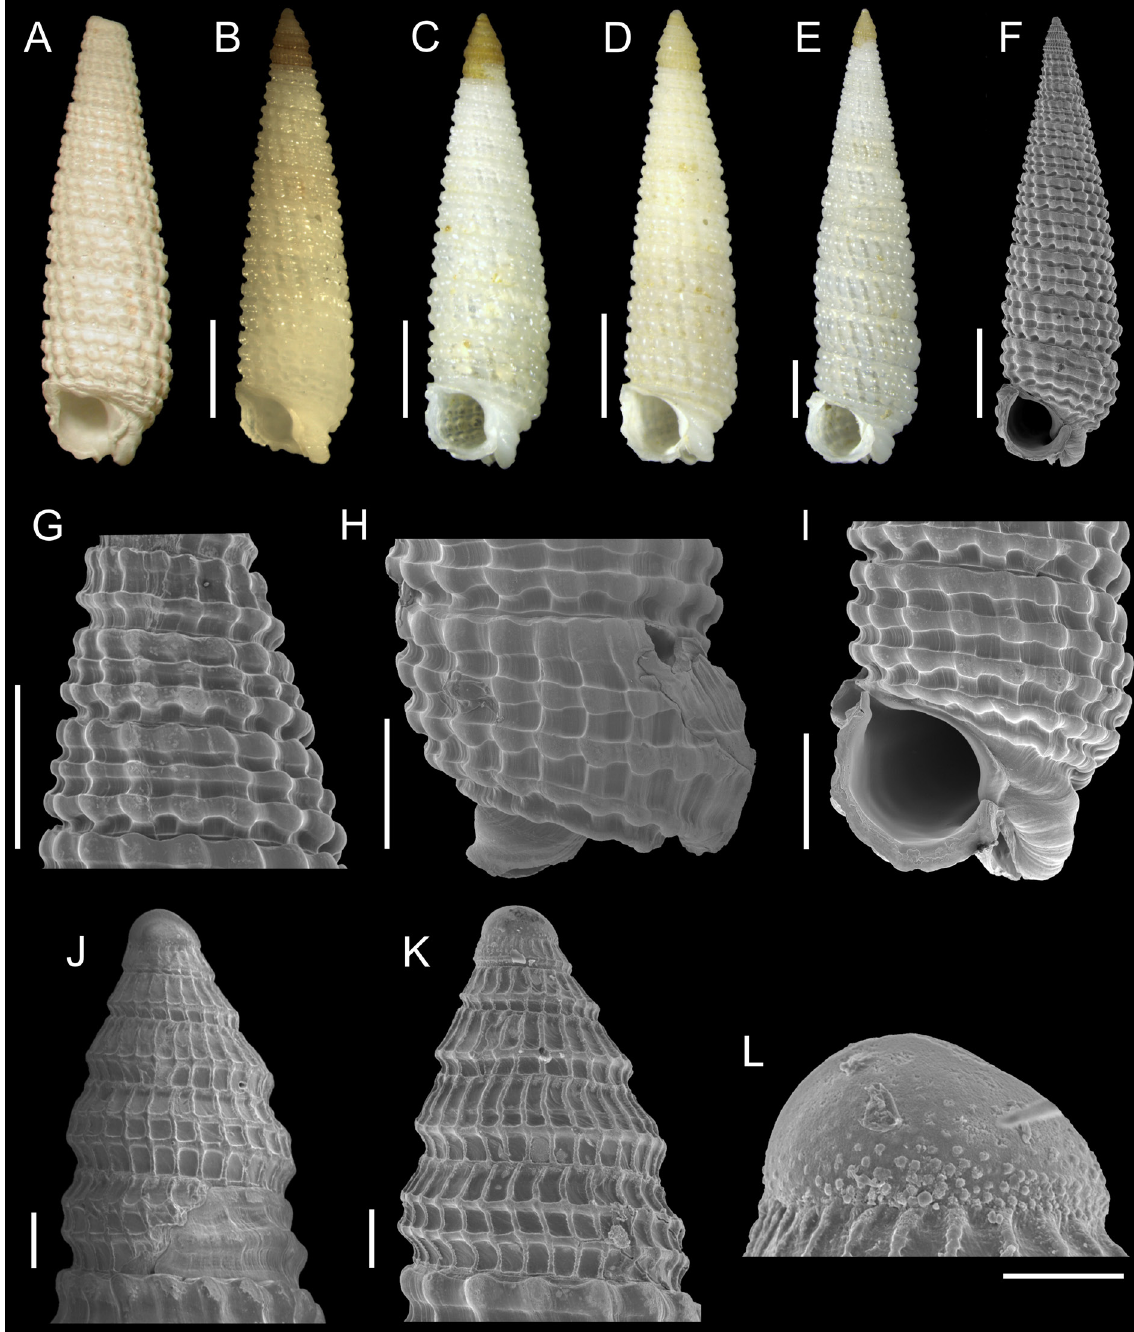
Fig. 88. Cosmotriphora melanura (C.B. Adams, 1850). A . Lectotype, MCZ 186159. B . MNRJ 18409*, 4.64 mm. C . MNRJ 31498*, 4.68 mm. D . MNRJ 32607*, 4.36 mm. E . MNRJ 32996*, 7.87 mm. F . MNRJ 18409*, 5.06 mm. G–I, K–L . Same shell as F. J . Same shell as E. Scale bars: B–F = 1 mm; G–I = 500 µm; J–K = 100 µm; L = 50